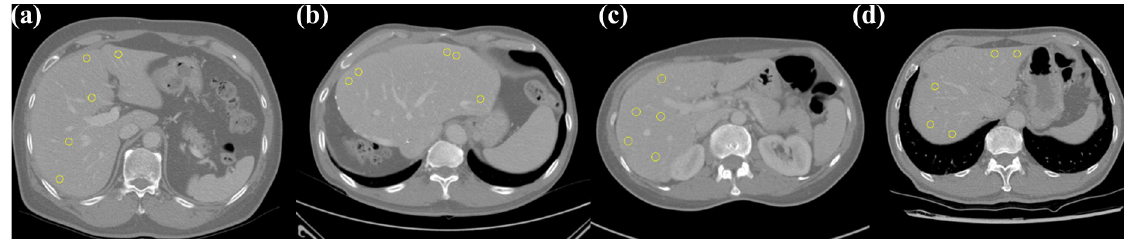
Fig 5. Sample homogeneous ROI extraction results on contrast-enhanced liver CT exams. The results were displayed for multi-vendor CT images acquired through (a) Scanner 1, (b) Scanner 2, (c) Scanner 3, and (d) Scanner 4, respectively.